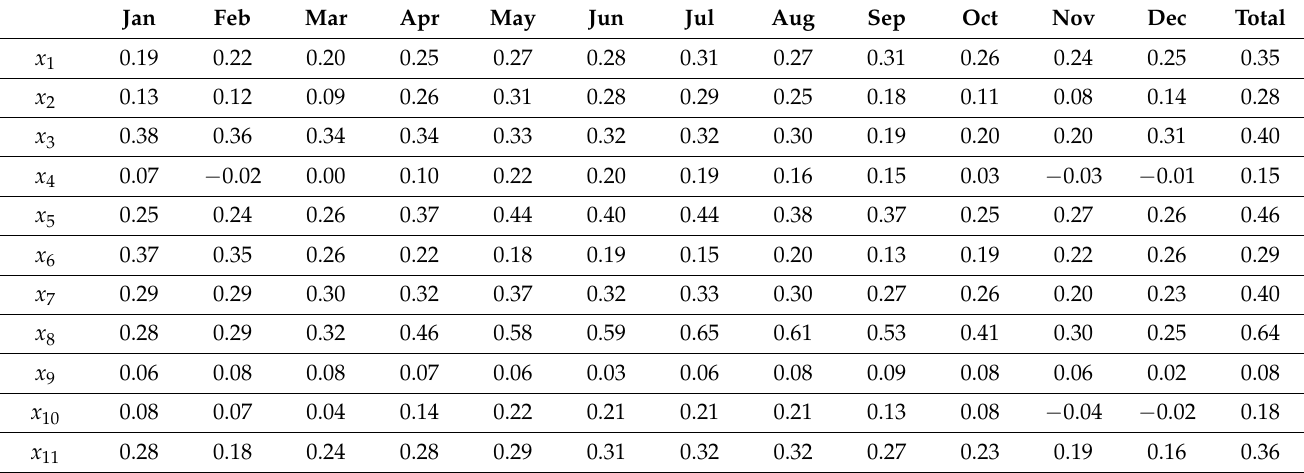
Table 5. Correlation (R) of household appliances with monthly and annual electricity